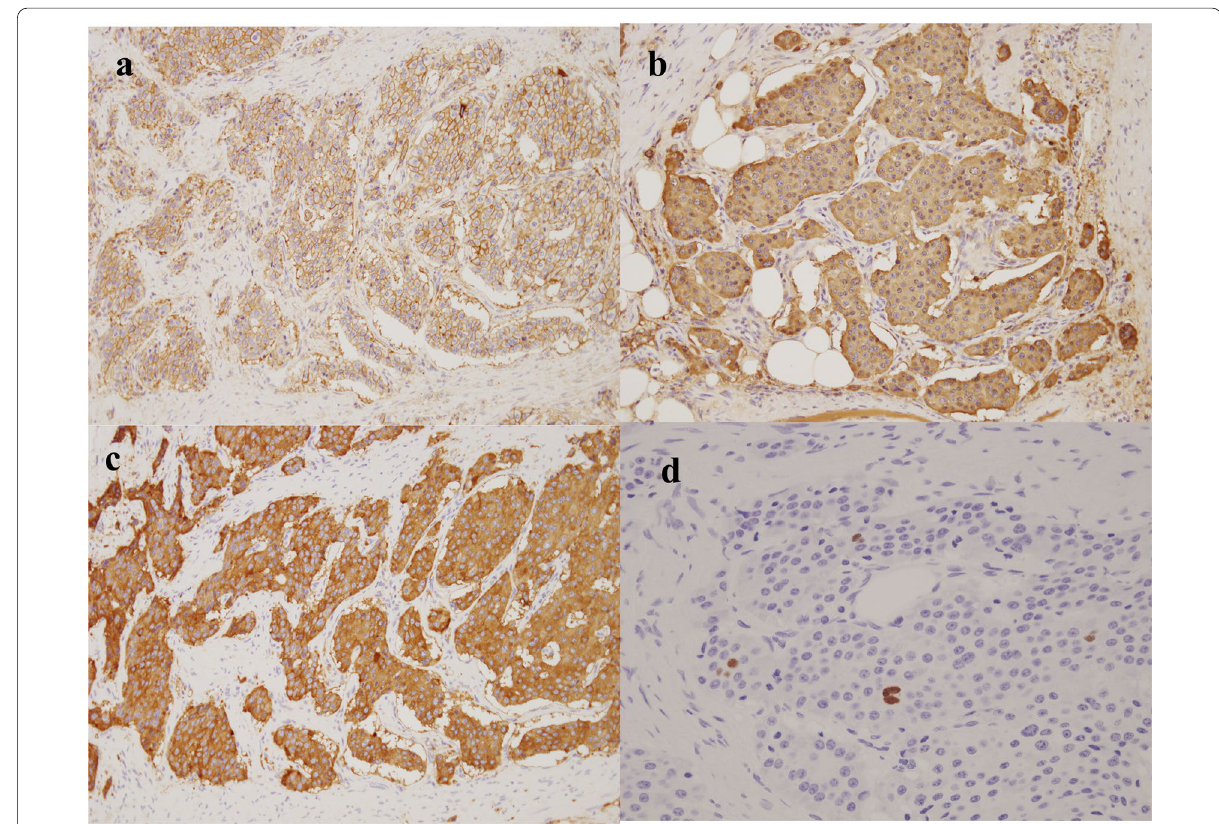
Fig. 6 Immunohistochemical staining is positive for the following: a ( The Ki-67 index is